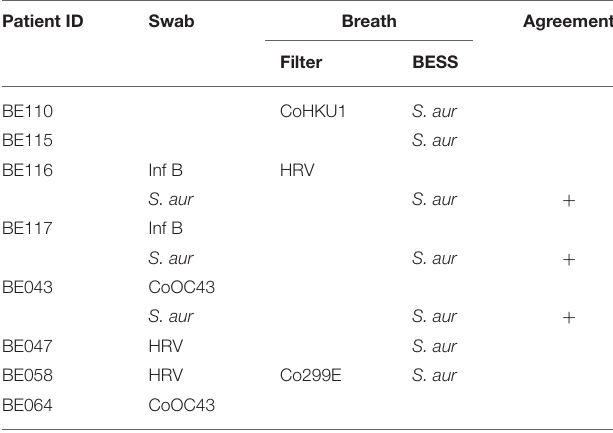
TABLE 1 | Results from the Fast Track Diagnostic respiratory pathogens 21 plus panel. Patient